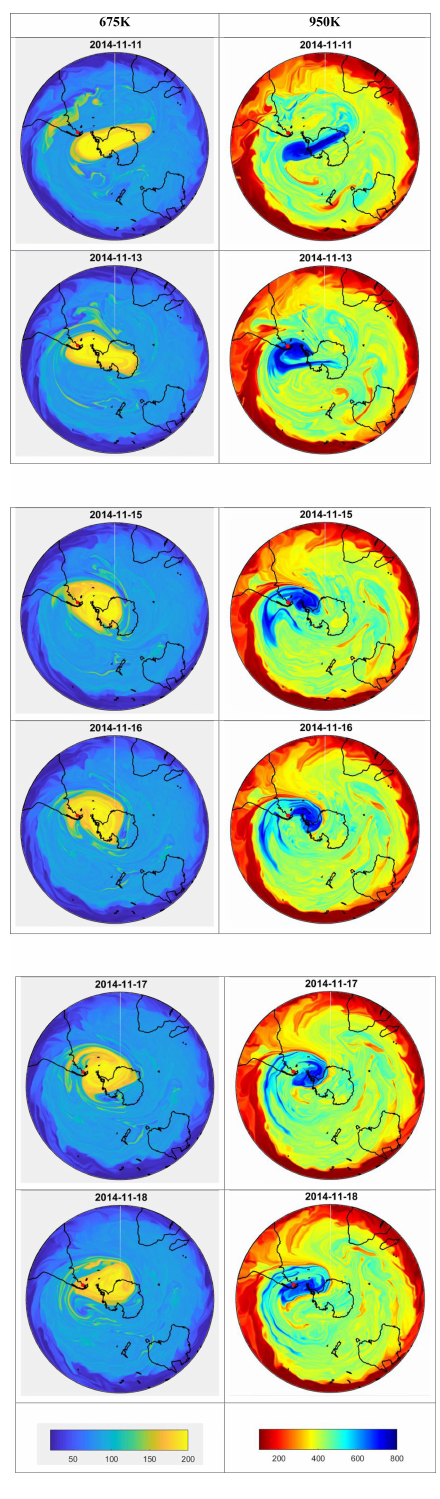
Figure 8. Advected potential vorticity maps assimilated with the MIMOSA model. Maps show the evolution of the polar vortex for two isentropic levels with potential temperatures of 675K (left) and 950K